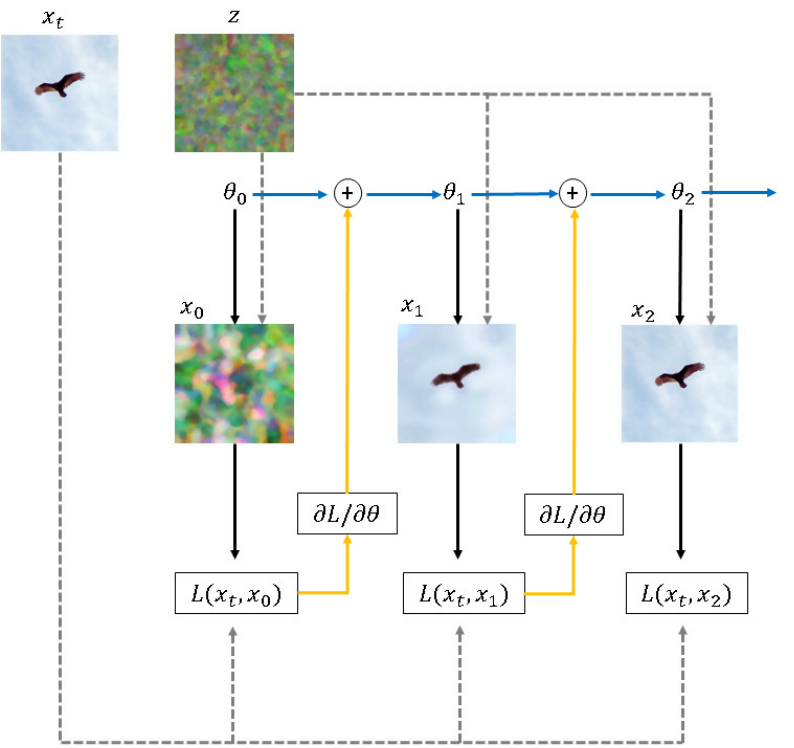
Figure 2. Overall procedure of